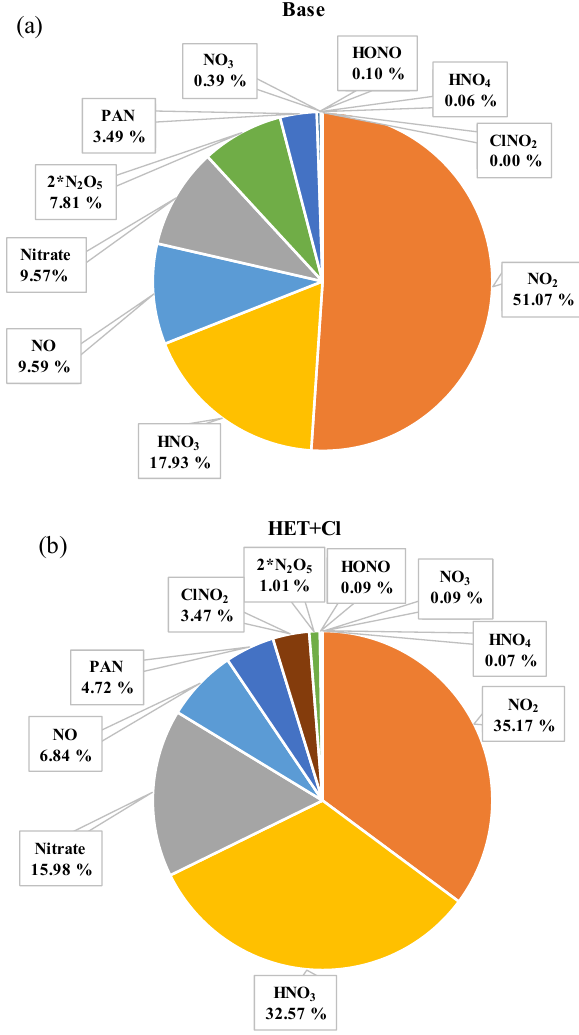
Figure 8. Average impacts of N 2 O 5 heterogeneous uptake on (a) NO (ppb), (c) NO 2 (ppb), (e) total nitrate (µgm − 3 ) and (g) O 3 (ppb) average concentrations during the simulation period in the horizontal domain within the PBL; average impacts of Cl activa- tion on (b) NO (ppb), (d) NO 2 (ppb), (f) total nitrate (µgm − 3 ) and (h) O 3 (ppb) average concentrations during the simulation period in the horizontal domain within the PBL.